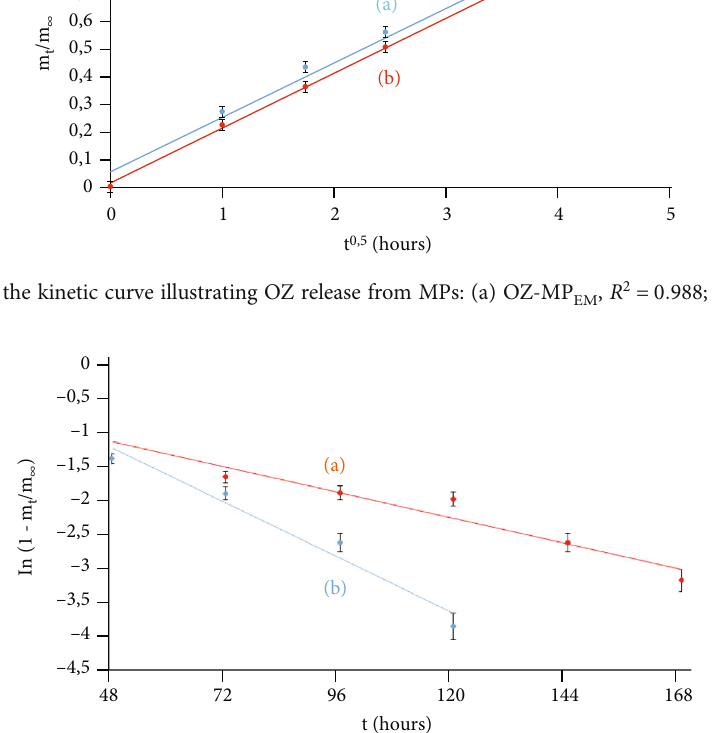
, R 2 = 0 : 960 ; (b) OZ-MP , R 2 = − 0 : 927 EM SD